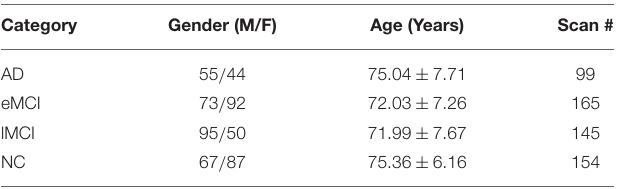
TABLE 1 | Demographic information of the involved 563 rs-fMRI scans from the ADNI database. Category